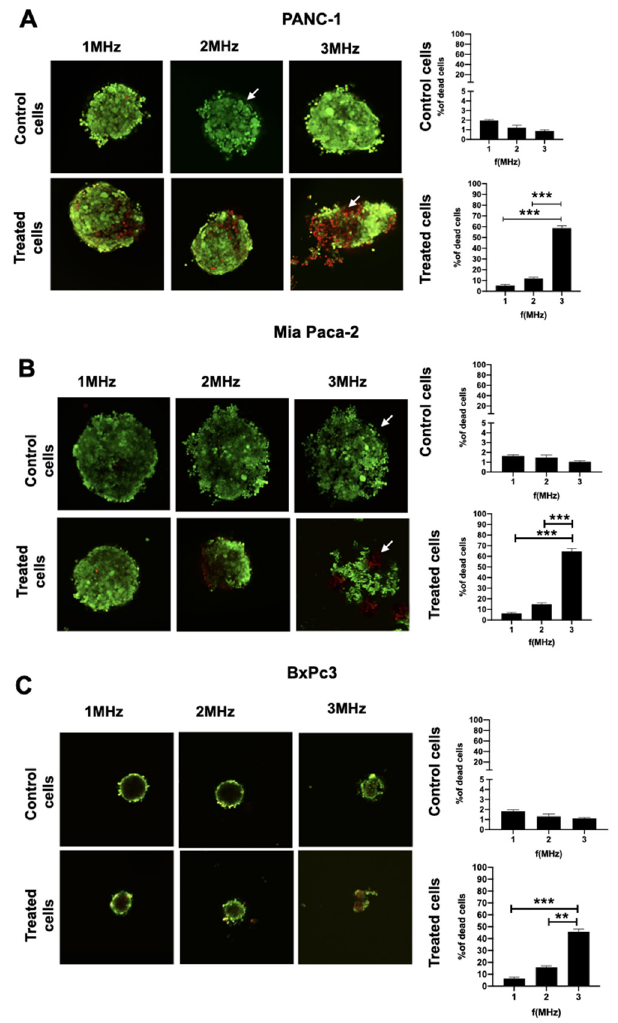
Figure 7. Images acquired with Confocal fluorescence microscope SP8 confocal microscope (Leica), showing PDAC cell spheroids. ( A ) PANC-1 spheroids, control upper panel and treated lower panel with 1, 2 and 3 MHz. In each well one spheroid was seeded, and images were acquired at 10x magnification. Control cells appear stained in green, which represents viable cells (see white arrows); while treated cells show a marked spotted red staining (see white arrow), which represent dead cells. Quantification of viable and dead cells using the BioFilmAnalyzer software is also reported. ( B ) Mia Paca-2 spheroids, control cells upper panel and treated cells lower panel, with 1, 2 and 3 MHz. In each well one spheroid was seeded, and images were acquired at 10× magnification. Control cells appear with a predominant green staining (see white arrow), indicating viable cells; while treated spheroids appear smaller and with a prevalence of red staining dots, indicating cell death (see white arrows). Mia Paca-2 spheroids, treated with 3 MHz frequency, also appear to disaggre- gate. Quantification of viable and dead cells using Spheroid Sizer (Mathlab) is also reported. ( C ) BxPc3 spheroids, control upper panel and treated lower panel with 1, 2 and 3 MHz. In each well one spheroid was seeded, and images were acquired at 10× magnification. Control cells appear stained in green, which represents viable cells (see white arrows); while treated cells show a marked spotted red staining. BxPc3 spheroids appear smaller, as per proper cell characteristics. Cell staining appears concentrated on the spheroid margins, as they are compact and have less dye permeable. Quantifi- cation of viable and dead cells using Spheroid Sizer (Mathlab) is also reported. Image size for all pictures: 900 × 900 μ m, acquired under 10× magnification. *** p < 0.001;** p < 0.01. During the US treatment, total disruption of some spheroids was found with a ca- dency of 25% within the treated population. The frequency seems to affect only the level of cell scattering, as shown in Figure 8. Overall, the morphology of the spheroids results